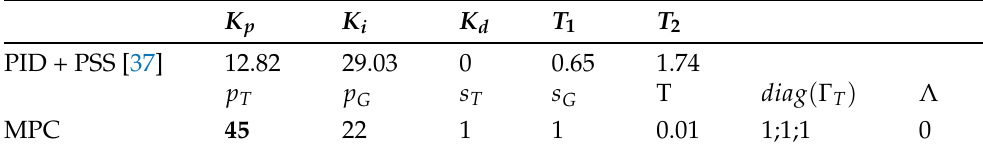
Table 5. Parameters of the controllers.